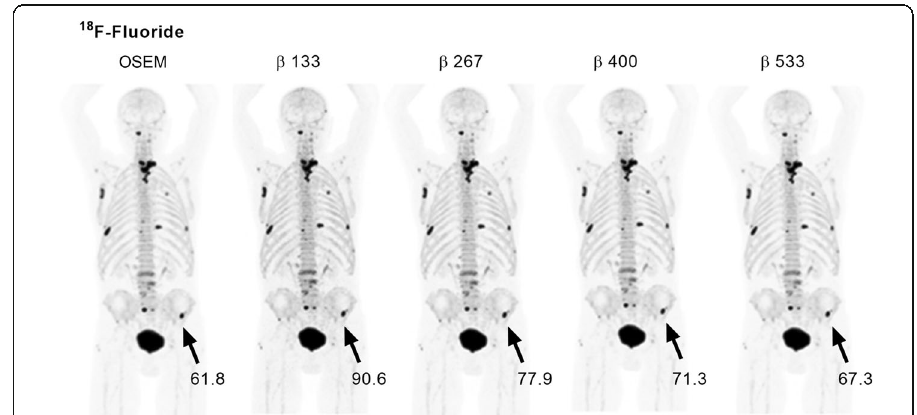
Fig. 6 Maximum intensity projection whole-body 18 F-fluoride PET images of a patient with prostate cancer bone metastases. Images were acquired 61 min post-injection and reconstructed with 2 min/bp using OSEM (3 iterations, 16 subsets, 5-mm Gaussian post-processing filter) and BSREM with β -values of 133, 267, 400, and 533. Both reconstruction methods included TOF and PSF recovery. The administered activity was 3.0 MBqkg − 1 . The SUV max of the lesion (arrow) is shown for the respective reconstruction